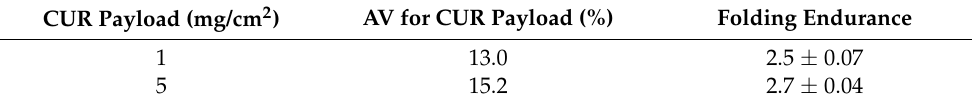
Table 4. CUR payload uniformity ( n = 10) and folding endurance of HP starch films ( n = 3).